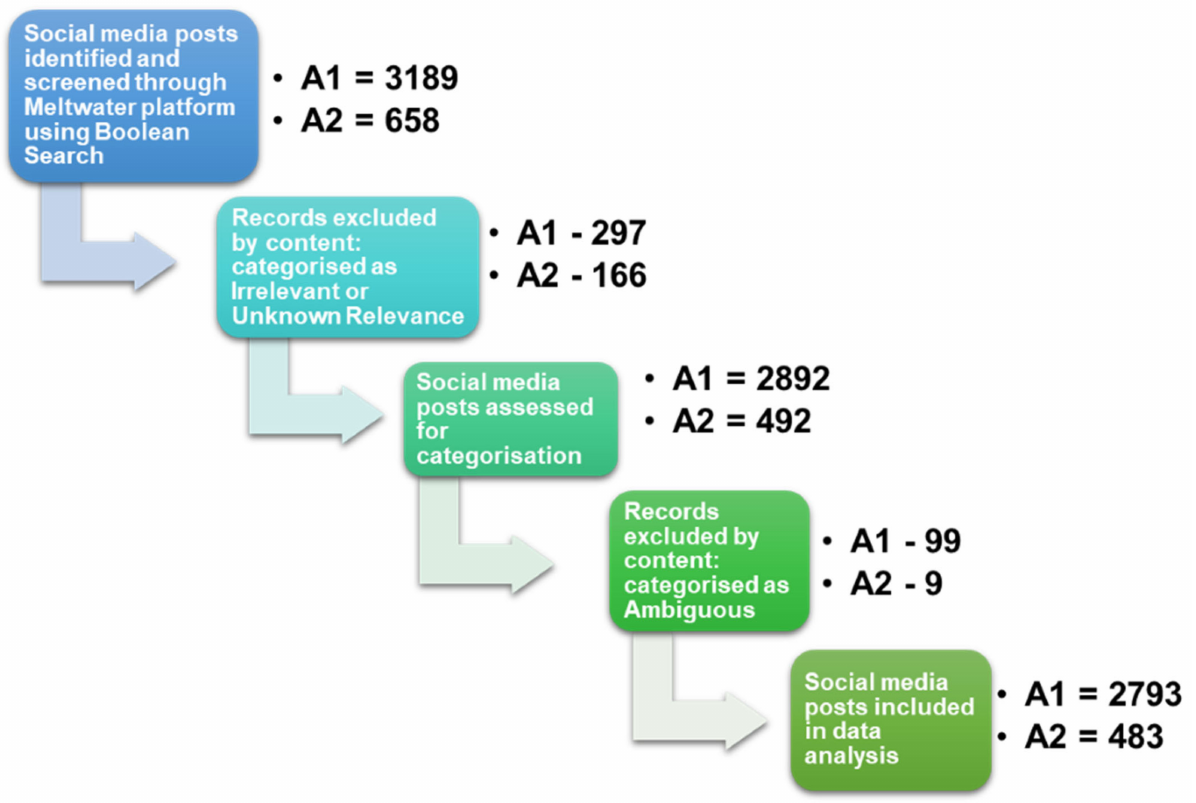
Figure 2. Flow diagram of the filtering process used to screen the digital and social media posts surrounding Annoucement-1 (A1) and Annoucement-2 (A2) collected from the Meltwater platform using the Boolean search. Posts that were excluded from the analysis were those categorized as irrelevant, unknown relevance and ambiguous. The ‘-’ sign in the figure represents the subtraction of the posts that were excluded from the analysis in each announcement. Remaining posts were analyzed and placed into one, or multiple of the seven categories: badger cull favorable or unfavorable, badger vaccine favorable or unfavorable, cattle vaccine favorable or unfavorable, or